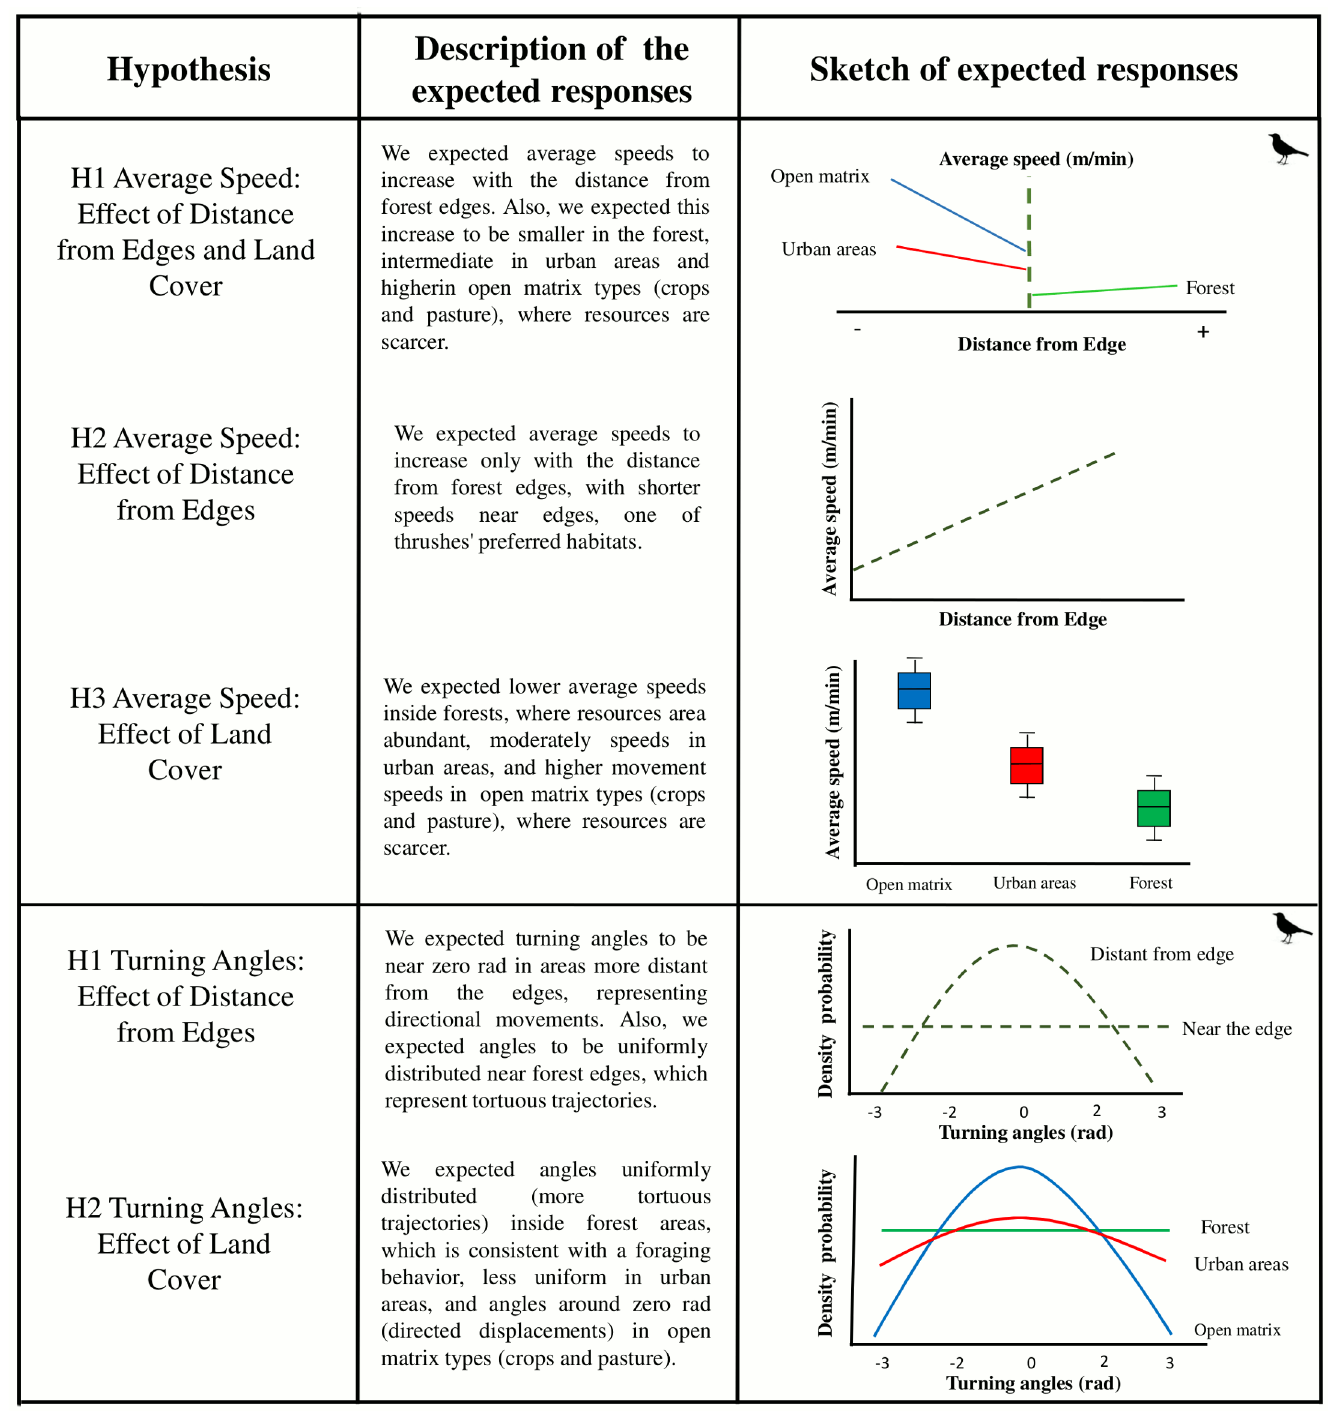
Fig 1. Predictions for average speed and turning angles of thrushes' trajectories in a fragmented landscape. Alternative hypotheses are explained and shown graphically considering the effects of land cover variables, land cover type, and distance to forest edges. In hypothesis H1 for average speed, zero values represent the contact area between two land cover classes (i.e. the